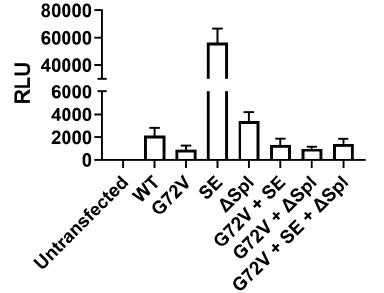
Figure 3. Enhanced sensitivity mutations with G72V optimises rtTA-M2 inducibility . HEK293T cells were stably transposed with pSBtet-GP:Luciferase with wildtype (WT) rtTA, or rtTA contain- ing the G72V mutation, high- sensitivity (SE) mutations, cryptic splice sites removed (ΔSpl), G72V and SE, G72V and ΔSpl, or G72V with both SE and ΔSpl. Untransfected or transfected HEK293T cells were incubated with a titration of doxycycline (Dox; 0, 0.1, 0.5, 1, or 5 μg/mL) for 24 h prior to the analysis of luciferase production. ( A ) Relative luminescence units (RLU) or ( B ) the luciferase fold change compared to nil doxycycline addition is shown with the mean and SD of three pooled experiments. Although the introduction of SE mutations alone into the rtTA-M2 construct resulted in greater levels of luciferase induction at lower levels of doxycycline, the basal expression compromised the fold-induction in transductants housing only the rtTA-M2 SE mutations (Figures 3 and 4). The addition of G72V to the SE-mutant rtTA mitigated the undesirable Figure 4. G72V minimises basal expression even in the presence of high sensitivity mutations basal expression of the SE rtTA-M2 noted in the absence of doxycycline (Figure 4). Abla- within the rtTA . HEK293T cells untransfected or stably transposed with pSBtet-GP:Luciferase with tion of cryptic splice sites did not appear to have an impact on absolute RLU or fold-ex- WT, G72V, SE, ΔSpl, G72V and SE, G72V and ΔSpl, or G72V with both SE and ΔSpl were analysed for basal levels of luciferase production. Relative luciferase units (RLU) are shown with the mean and SD of three pooled experiments.